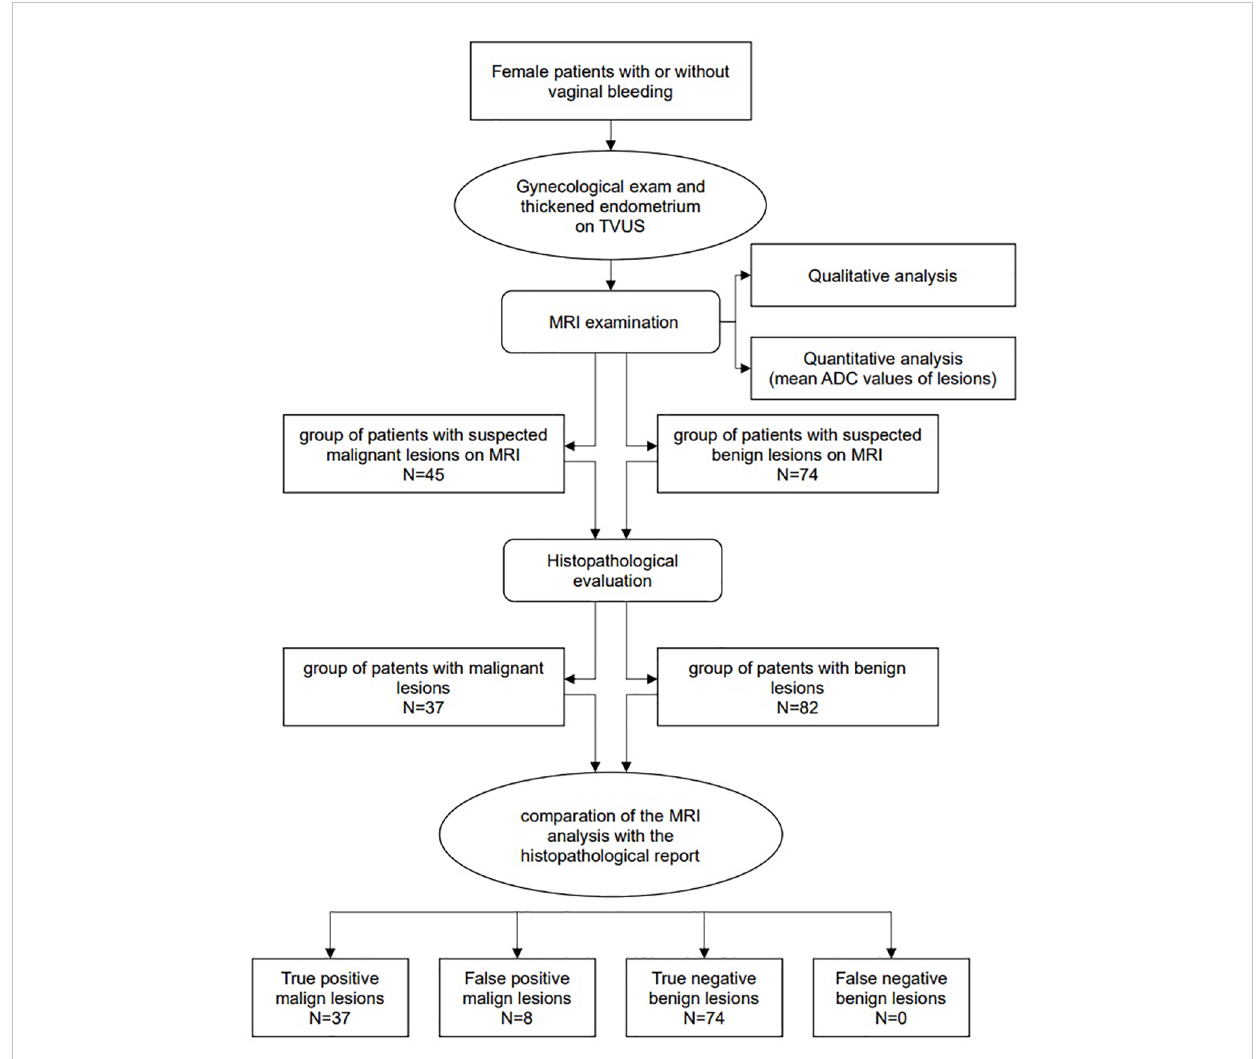
FIGURE 1 The general fl owchart shows the methodological steps of the